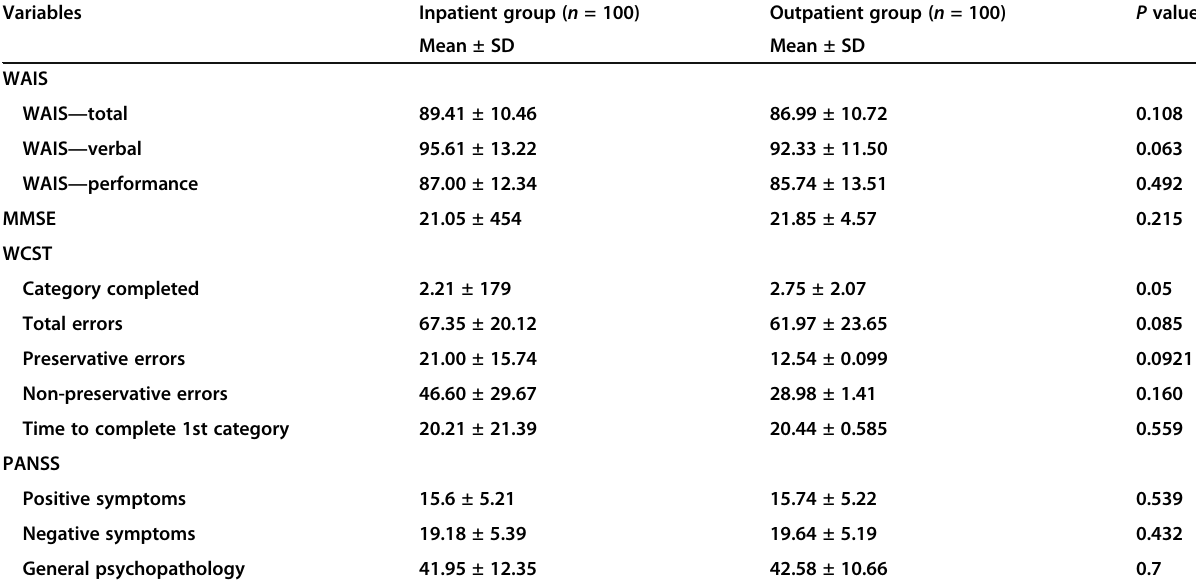
Table 2 Comparison of neuro-cognitive function subtests across inpatient and outpatient groups Variables